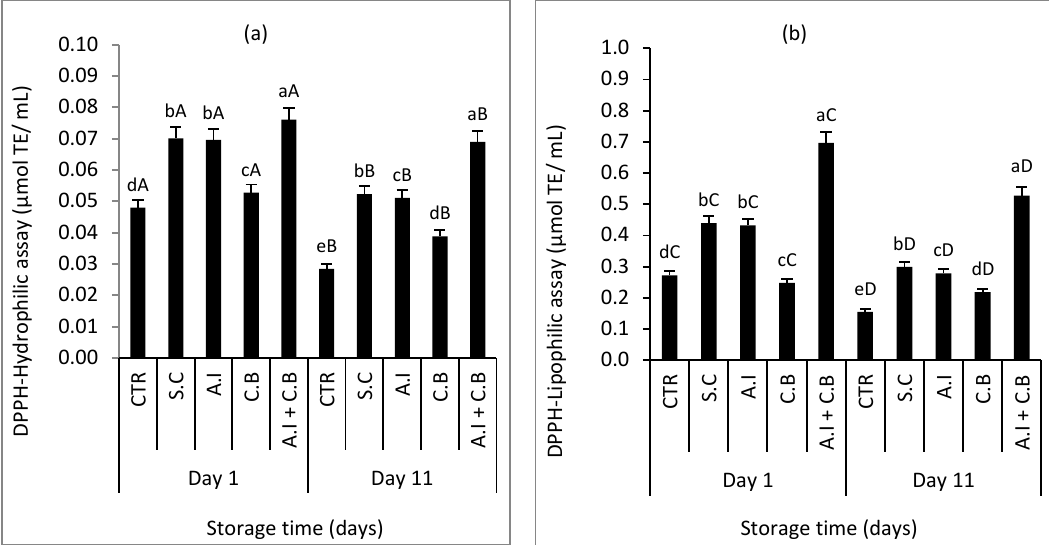
Figure 3. Antioxidant capacity (AOC) measurements by DPPH-Hydrophilic ( a ) and DPPH-Lipophilic ( b ) assays of raw beef patties during storage at 4 ± 1 ◦ C. CTR (Control sample without antioxidant), S.C (treatment with 0.7% (w / w) synthetic conservative), A.I (treatment with 0.7% (w / w) powdered A. indica leaves), C.B (treatment with 0.7% (w / w) powdered C. baccatum fruits) and A.I + C.B (treatment with 0.7% (w / w) powdered A. indica leaves and 0.7% (w / w) powdered C. baccatum fruits). Results represent the mean of three replicates ( n = 3) and are expressed as mean value ± SD; di ff erent letters in the same day indicate significant di ff erences between samples at p < 0.05, di ff erent capital letters indicate significant di ff erences between storage days at p < 0.05 for the same sample.